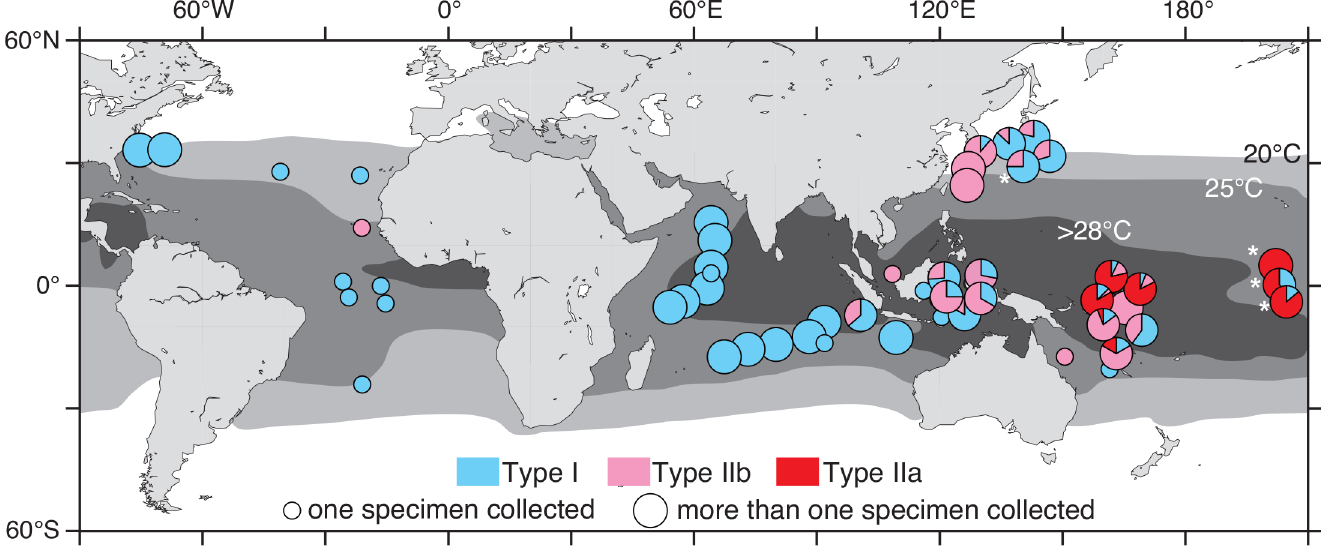
Fig 1. Geographic distribution of the three genetic types of P . obliquiloculata . Pie chart shows the frequencies of three genetic types at each sampling site based on the previous studies [5,28]. The small and large circles indicate the locations where only one or more specimens were collected. The asterisks show the locations, where the samples were obtained for the present study. The genetic types of P . obliquiloculata specimens from Seears et al. [28] were identified based on the alignment of the partial SSU rDNA sequences with all existing data of Ujiié et al. [5]. Grey areas on the map show the ranges of water temperatures between 20 – 25, 25 – 28, and > 28°C. The temperature data were obtained from the World Ocean Atlas 2005 [29]. The map is drawn by using the Ocean Data View